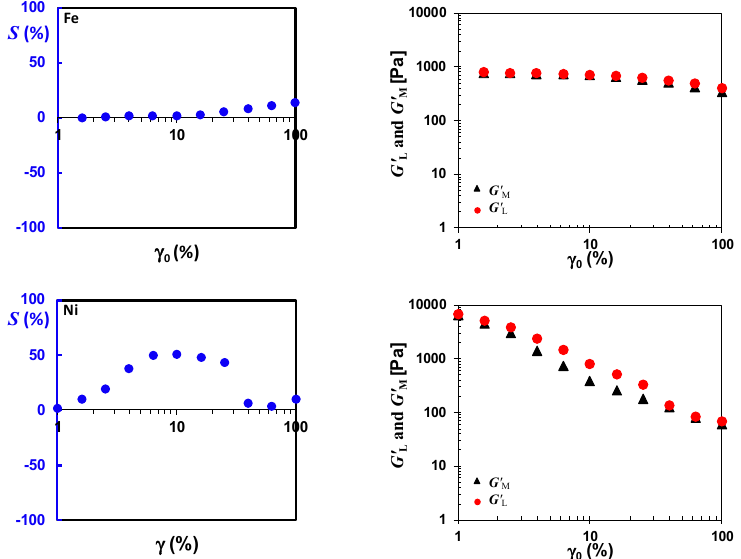
Figure 7. Elastic ( S ) intra-cycle nonlinearity index and nonlinear viscoelastic measures of 𝐺 (cid:3013)(cid:4593) and 𝐺 (cid:3014)(cid:4593) as a function of imposed strain amplitude for (N-CNT) Fe /PVDF and (N-CNT) Ni /PVDF nanocomposites containing 2.0 wt% of carbon nanotubes using cone-plate geometry (a truncation of 47 μ m) at an angular frequency of 𝜔 = 0.1 rad/s at 240 °C.